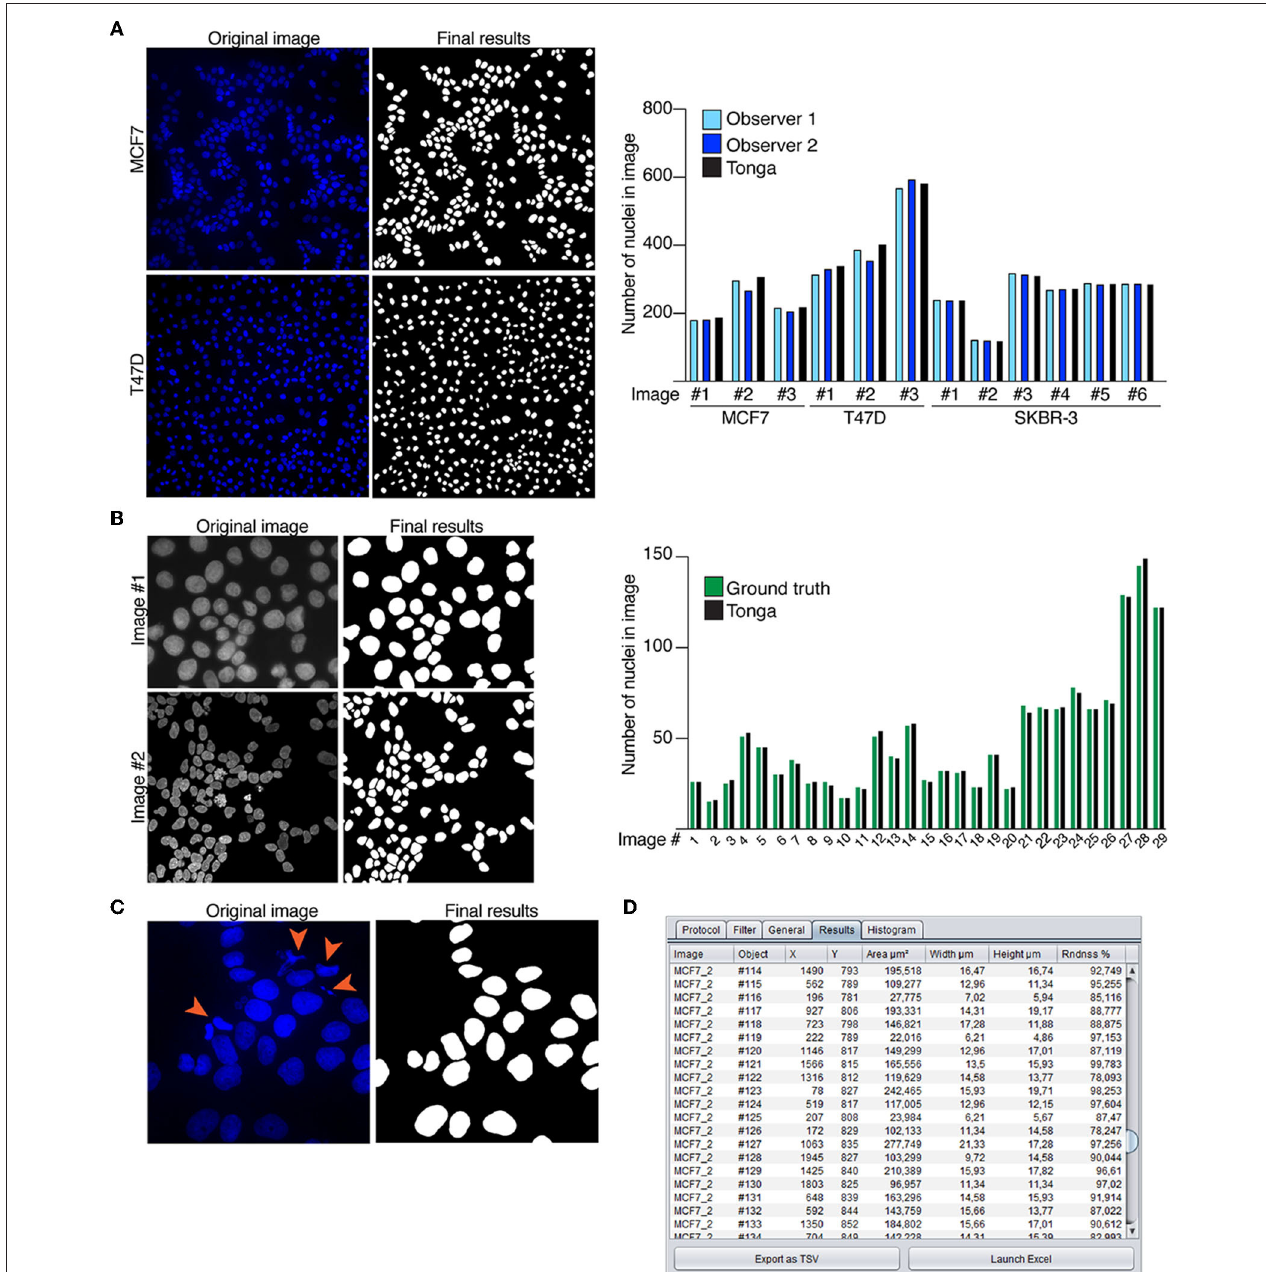
FIGURE 3 | Nuclear segmentation protocols. (A) Example images of MCF7 and T47D breast cancer cells with nuclear stain (Hoechst) and corresponding segmentation masks by Tonga. Graph shows quantitation of round nuclei in 12 independent images. Counting was performed manually by two observers, and compared to count by Tonga. (B) Example images of Kromp et al. (2020) data set and the final segmentation results created in Tonga. Graph shows nuclear count of 29 images by Tonga compared to the ground truth. (C) Example image of MCF7 with nuclear stain (Hoechst). Dividing and apoptotic cells indicated by orange arrowheads in the original image are removed from the final results. (D) Numeric output from the nuclear segmentation protocol shown in the results tab.